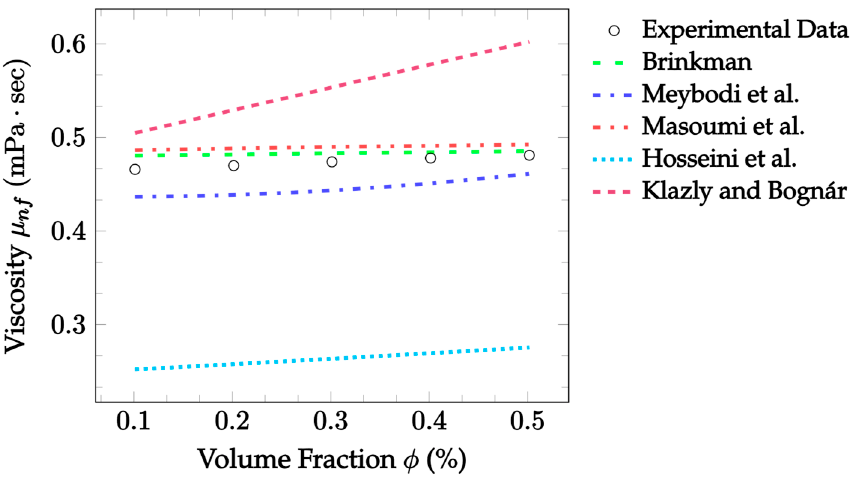
Figure 17. Experimental findings for Fly ash–water nanofluid compared with theoretical predictions: Experimental Data [107], Brinkman [48], Meybodi et al. [49], Masoumi et al. [50], Hosseini et al. [51], Klazly and Bognár [52]. Table 8. Level of accuracy (%) of each nanofluid viscosity model when compared against given experimental